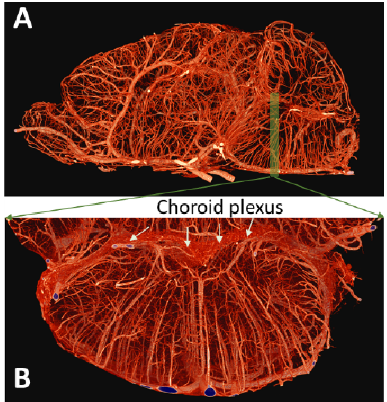
Figure 2. High-resolution micro-CT-based cerebrovascular mapping in the mouse brainstem. ( A ) Sagittal view and ( B ) coronal view of vascular structure supplying the superior dorsal pontine area), adapted from Hlushchuk et al. 2020.